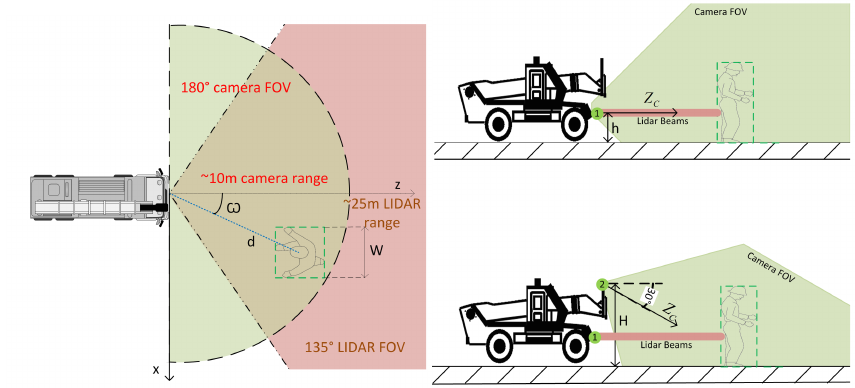
Figure 3. Sensor configuration map. Sensor heights are h = 110cm and H = 210cm,